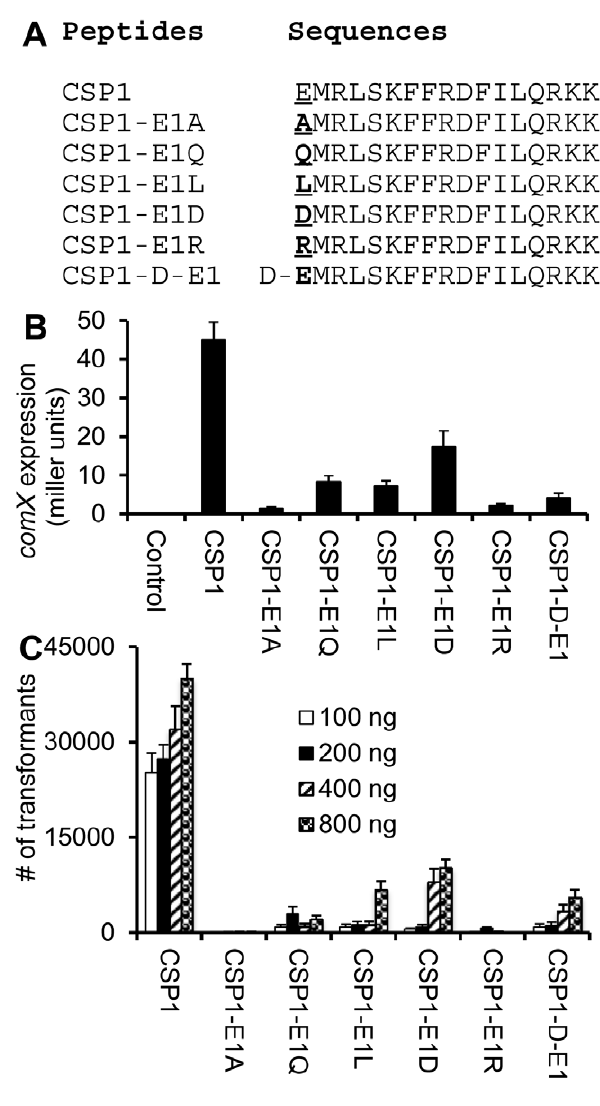
Figure 4. The negative charge and enantiomericity of gluta- mate residue in the first position is important for the activity of CSP1. (A) Amino acid substitutions of the first glutamate residue in CSP1. (B) Induction of comX expression by CSP1 analogs. D39pcomX::- lacZ were incubated with CSP1 or with each glutamate substituted analog at a final concentration of 100 ng/ml. The ability of each peptide to induce the competence regulon was measured by induction of the comX by ß-galactosidase assays. (C) Genetic transformation of D39 cells in the presence of indicated concentrations of CSP1 and its analogs using the rpsL gene. Transformants were selected on THB agar containing 100 m g/ml streptomycin. Experiments in B and C were performed in triplicates and repeated three times. The means 6 SD of one typical experiment are shown.